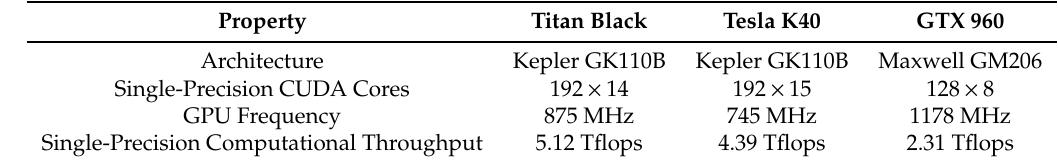
Table 7. Hardware configuration and capabilities of the three